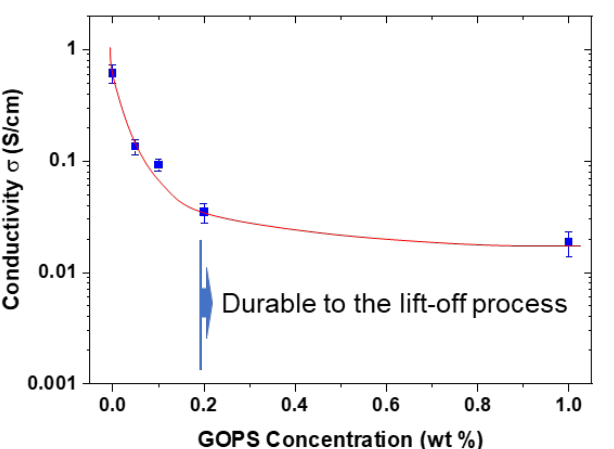
Figure 3. Changes in conductivity of PEDOT:PSS films when (3-glycidyloxypropyl)trimethoxy- silane (GOPS) is added to PEDOT:PSS suspensions. The solid curve is a visual guide.